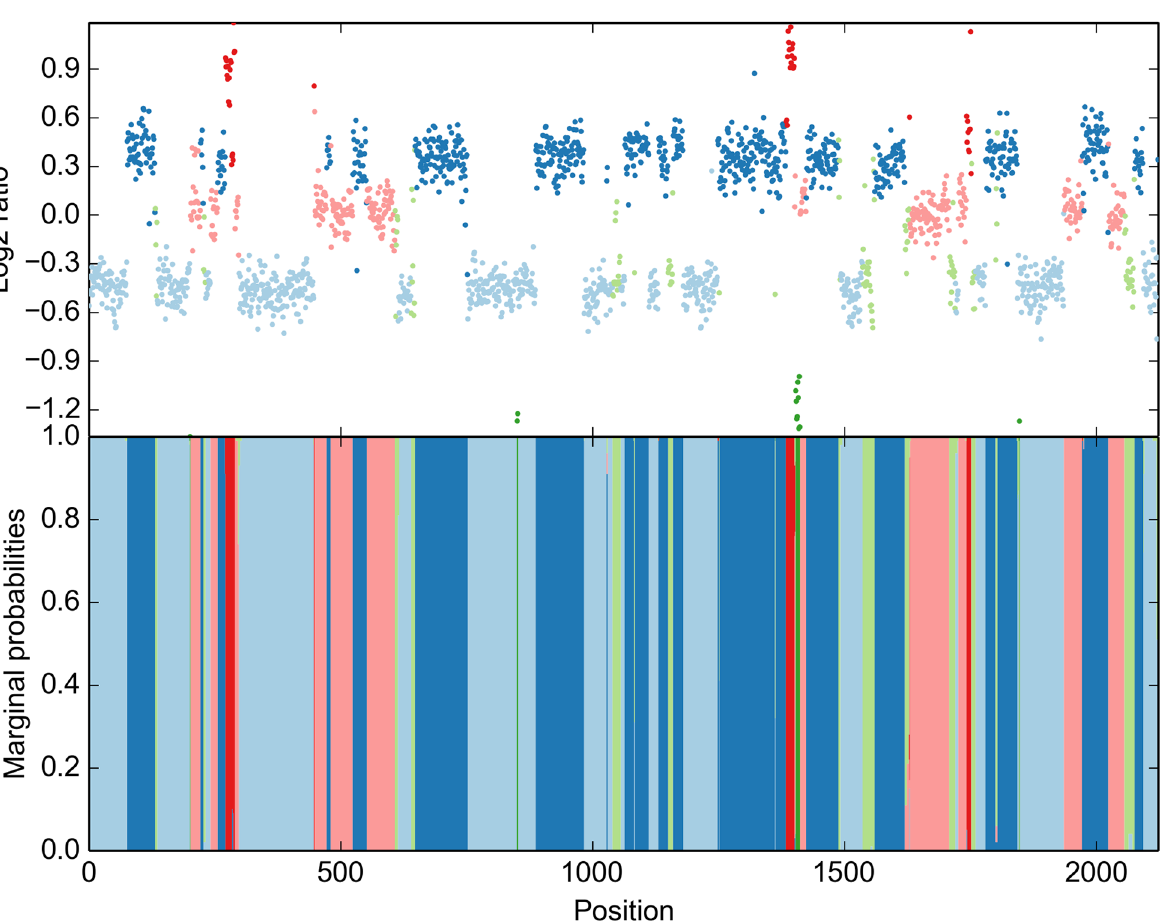
Fig 6. HaMMLET ’ s inference of copy-number segments on T47D breast ductal carcinoma. Notice that the data is much more complex than the simple structure of a diploid majority class with some small aberrations typically observed for Coriell data.